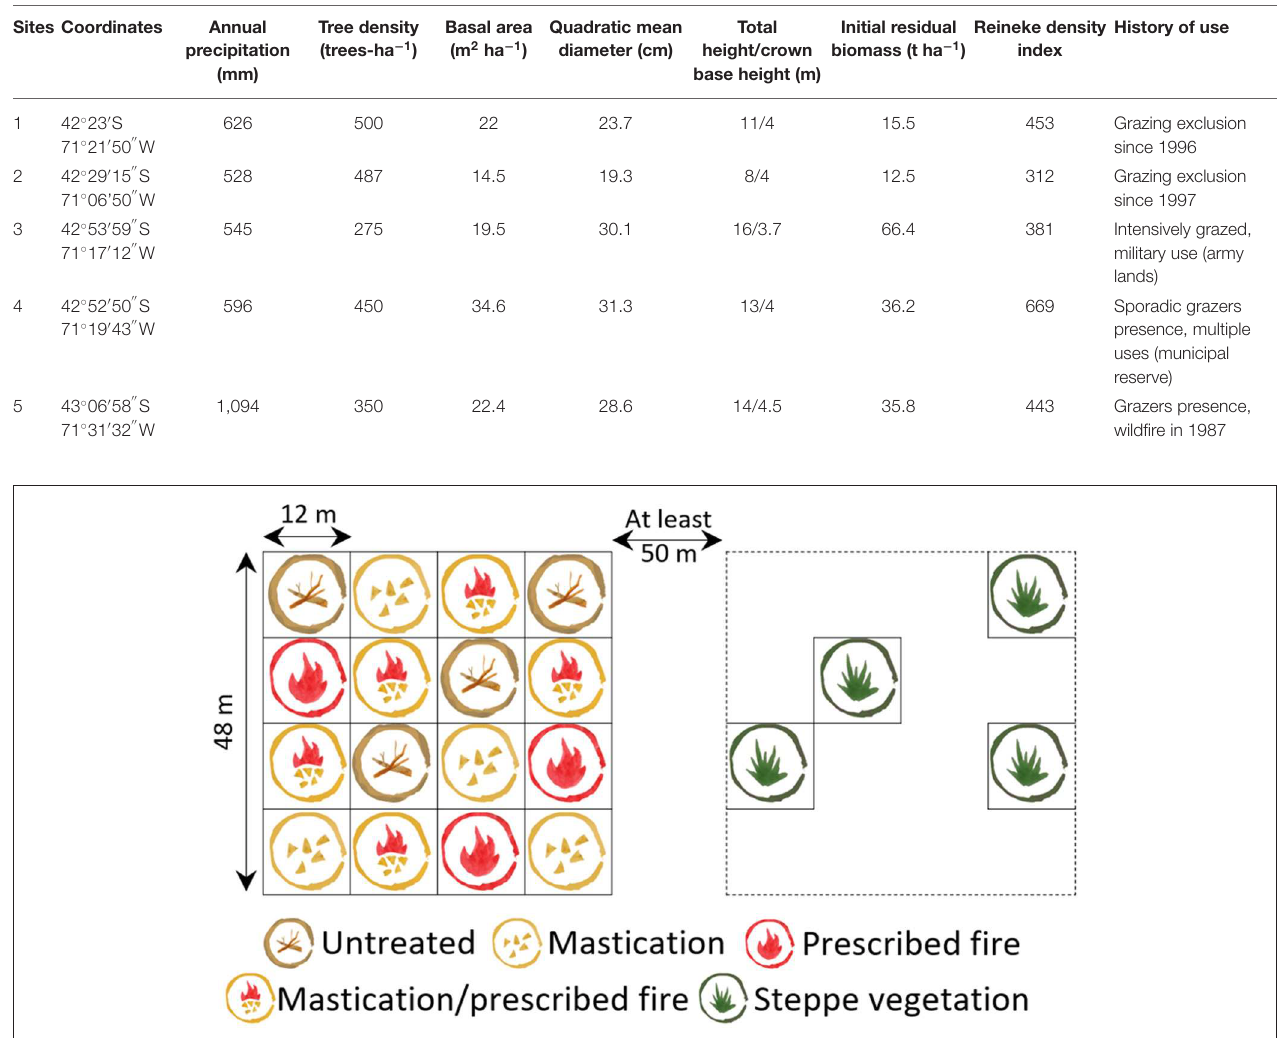
TABLE 1 | Environmental, forest structure, and site-specific characteristics at each study site. Sites Coordinates